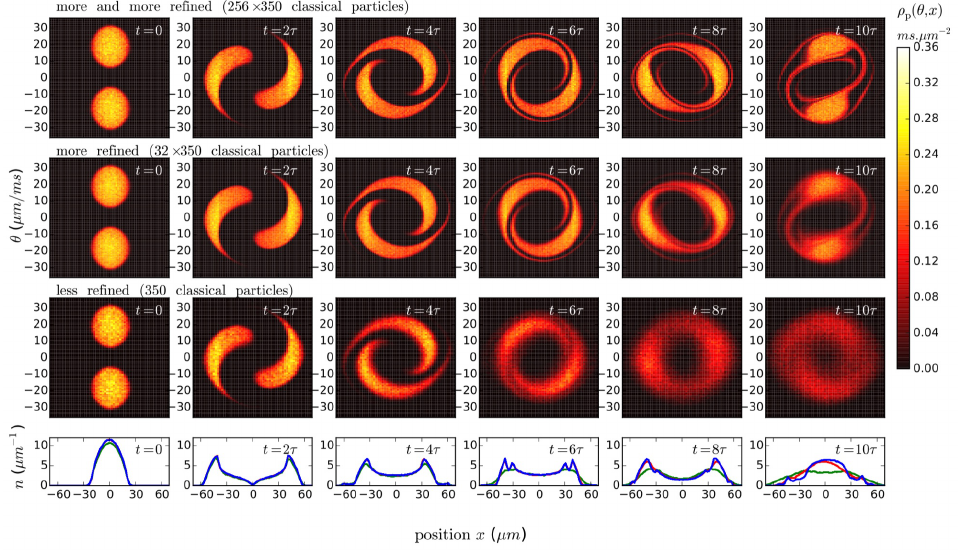
( θ , x ) obtained from three different micro- Figure 6: Comparison of the density ρ p scopic realizations of the same GHD equation (anharmonic case): the lower one (“less refined”) is our molecular simulator with 350 classical particles, the middle one (“more refined”) is with 32 × 350 classical particles, and the top one (“more and more refined”) is with 256 × 350 classical particles. The latter is the one shown in the main text in Figs. 1 and 2. The corresponding density profiles are plotted below (green: 350 class. part., red: 32 × 350 class. part., blue: 256 × 350 class. part.). As ( θ , x ) converges to the true GHD solution. the discretization is refined, the density ρ p A given discretization with a finite UV cutoff cannot resolve the fine structures that appear in GHD at scales smaller than the cutoff. However, GHD remains valid at larger scales, and this then amounts to